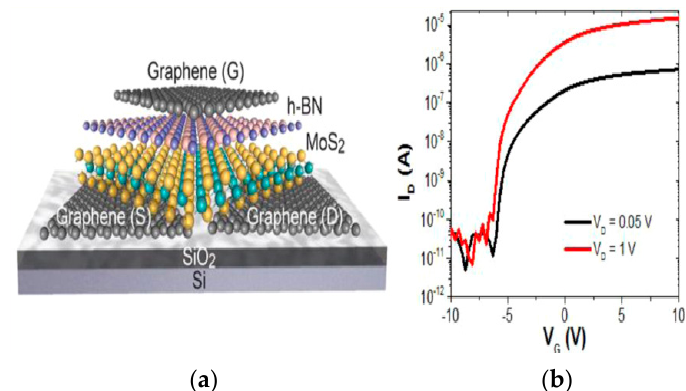
Figure 35. ( a ) Schematic of advanced 2D stacks and ( b ) characteristic curves of the transistor.